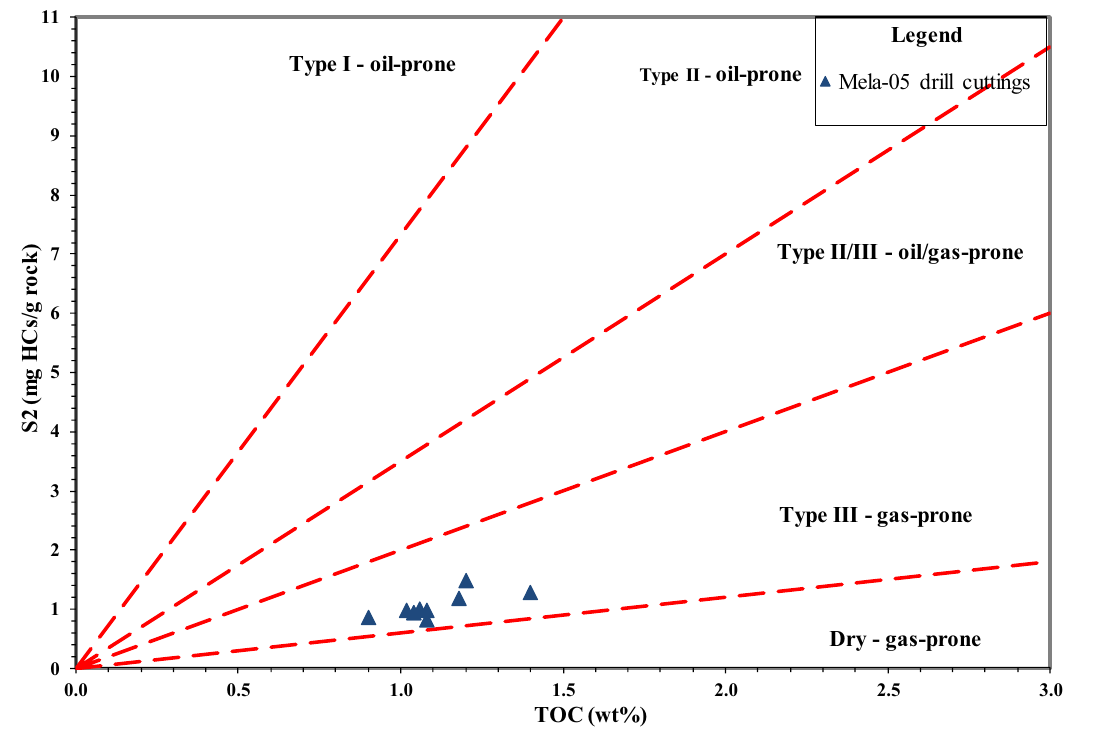
Fig. 5 The S 2 versus TOC cross-plot, showing the current kerogen type in the Mela-05 drill cuttings of the Chichali Formation (after Langford and Blanc-Valleron 1990)